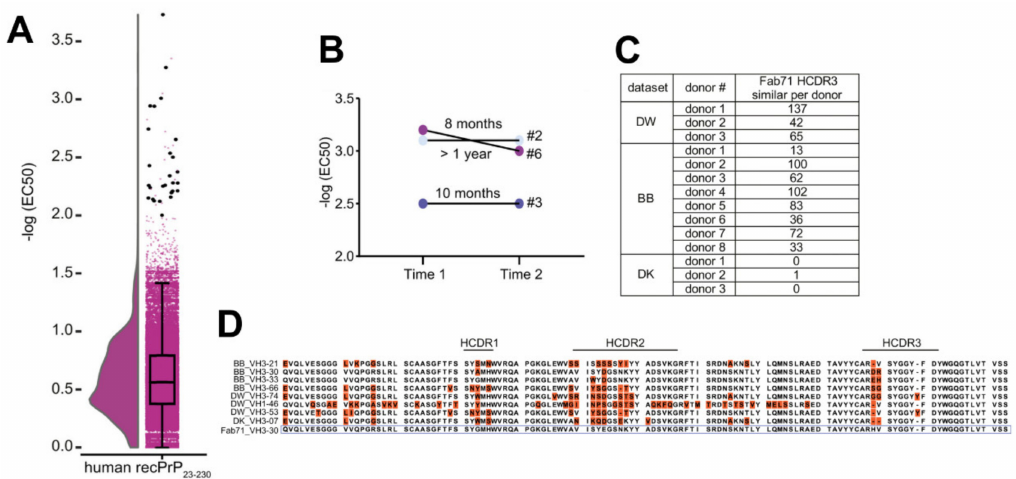
Figure 9. Detection of protective anti-PrP antibodies in human serum and immunoglobulin repertoires [270]. ( A ) Violin plot / box plot showing detection of 21 individuals (solid black circles) with high-titre anti-PrP antibody titres in serum samples from 41,718 Swiss hospital patients. ( B ) Anti-PrP reactivity was maintained for at least 8 months in some individuals. ( C ) Identification of HCDR3 sequences similar to a synthetic phage-derived anti-PrP Fab clone (Fab71) in three di ff erent datasets of human antibody repertoires from healthy donors. ( D ) The amino acid sequence of Fab17 VH3-30 compared to the HCDR3 regions identified in the di ff erent healthy donor databases that di ff ered from Fab71 by ≤ 3 residues. Orange boxes indicate amino acids distinct from Fab71. Adapted from [270] under the terms of the Creative Commons Attribution Licence (CC-BY-4.0; https: // creativecommons.org / licenses / by / 4.0 /